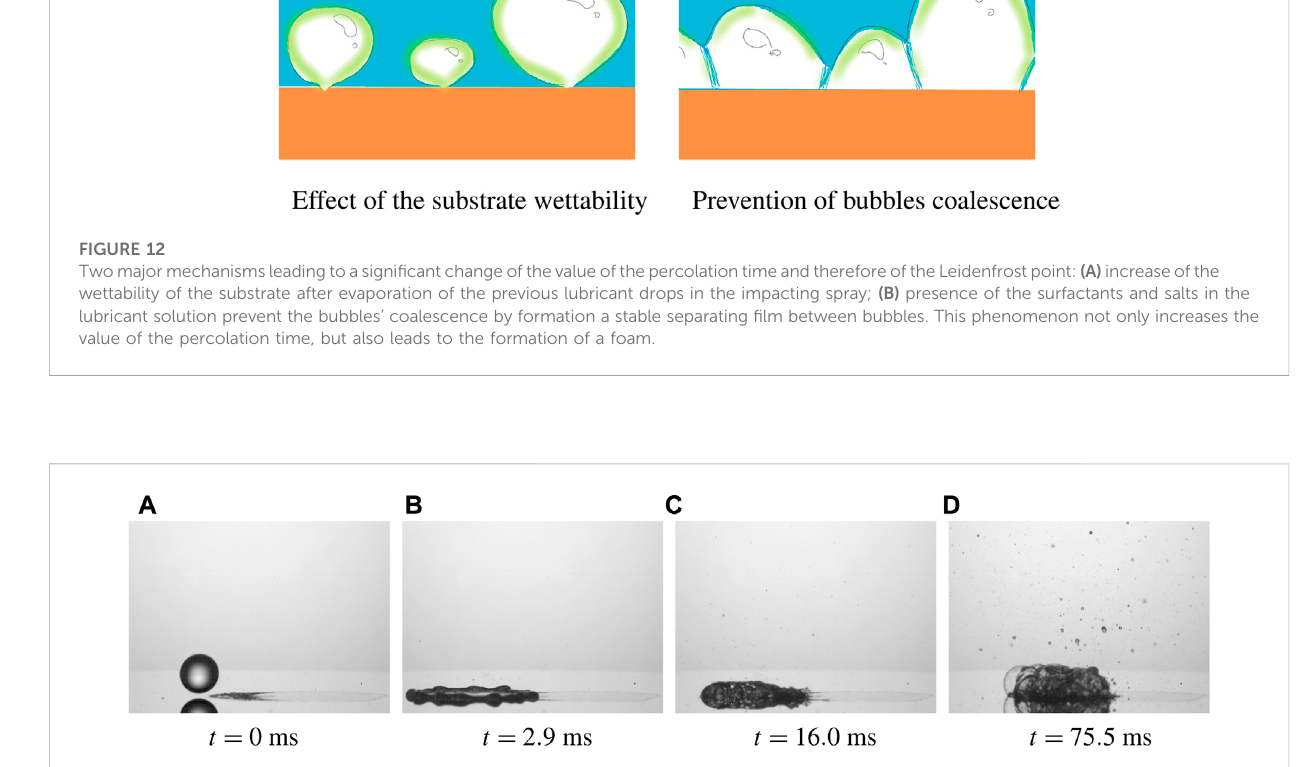
FIGURE 13 Different stages of distilled water drop onto a solid deposited layer from the impact of solution φ = 2.34% at the moment of impact (A) , 2.0 ms after impact (B) , 16 ms (C) and 76ms after impact (D) . The impact parametersare d 0 = 2.2 mm, impactvelocity U 0 = 1.7 m/sand initial wall temperature170 ° C. The corresponding video is in the Electronic Supplementary Material